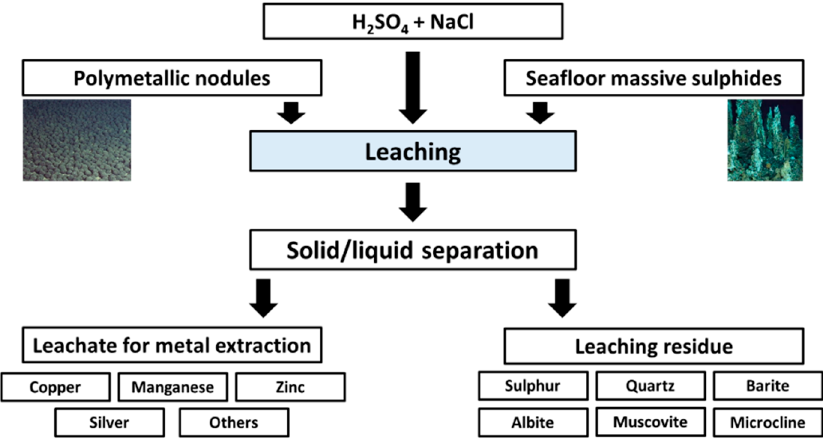
Figure 9. Simplified conceptual flowsheet of simultaneous leaching of seafloor massive sulfides (SMS) and polymetallic nodules (PN).